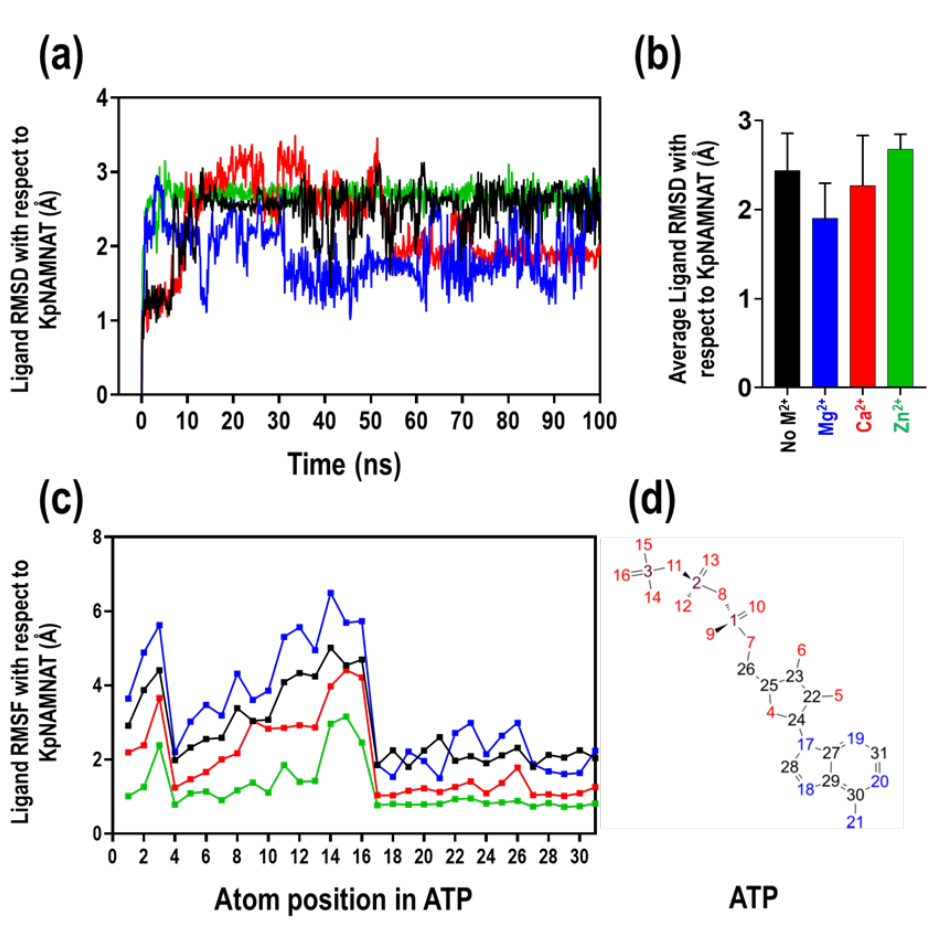
Figure 8. Trajectory analysis showing ( a ) the RMSD of ATP with respect to KpNNAT ( b ) the RMSF of ATP with respect to KpNNAT ( c ) the average RMSD of ATP with respect to KpNNAT in the absence of metal ion (black) and presence of Mg 2+ (blue), Ca 2+ (red), and Zn 2+ (green). The plots were generated using GraphPad Prism. ( d ) Numbering of the ATP molecule in relationship with ( c ). The highly fluctuating atoms of ATP are indicated in red. Image was generated from Schrödinger Maestro 2D diagram.